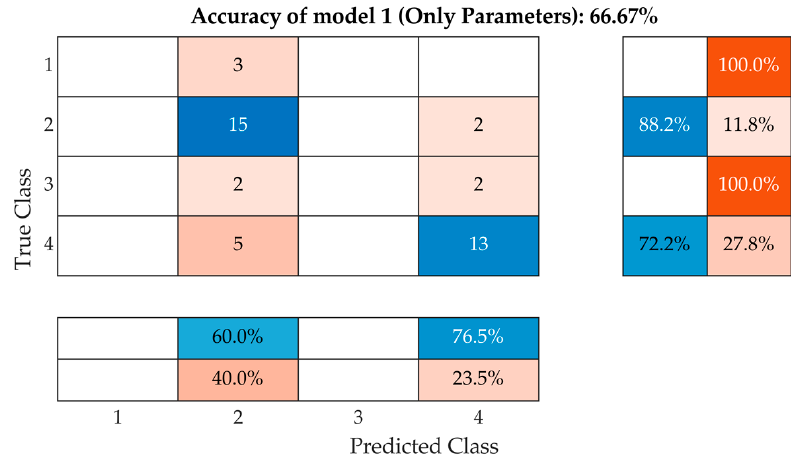
Figure 17. A model with parameters extracted from f L without statistical parameters and score values.